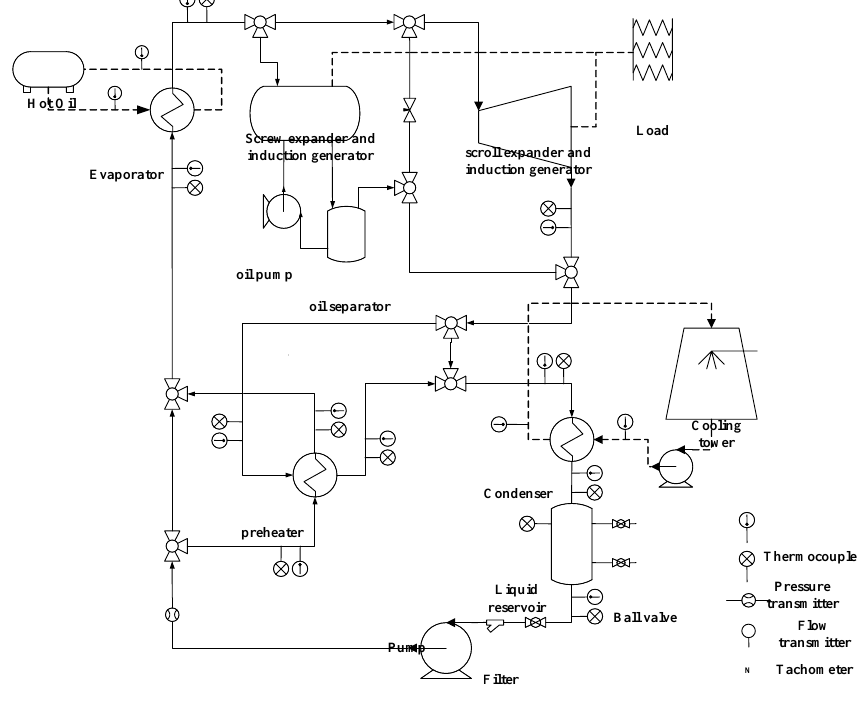
Figure 1. Schematic diagram of the experimental bench.